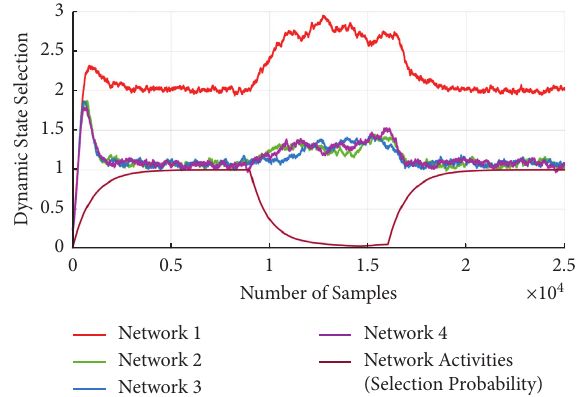
Figure 23: Effect of threshold on network connectivity for threshold � 2 ( S l � 10).